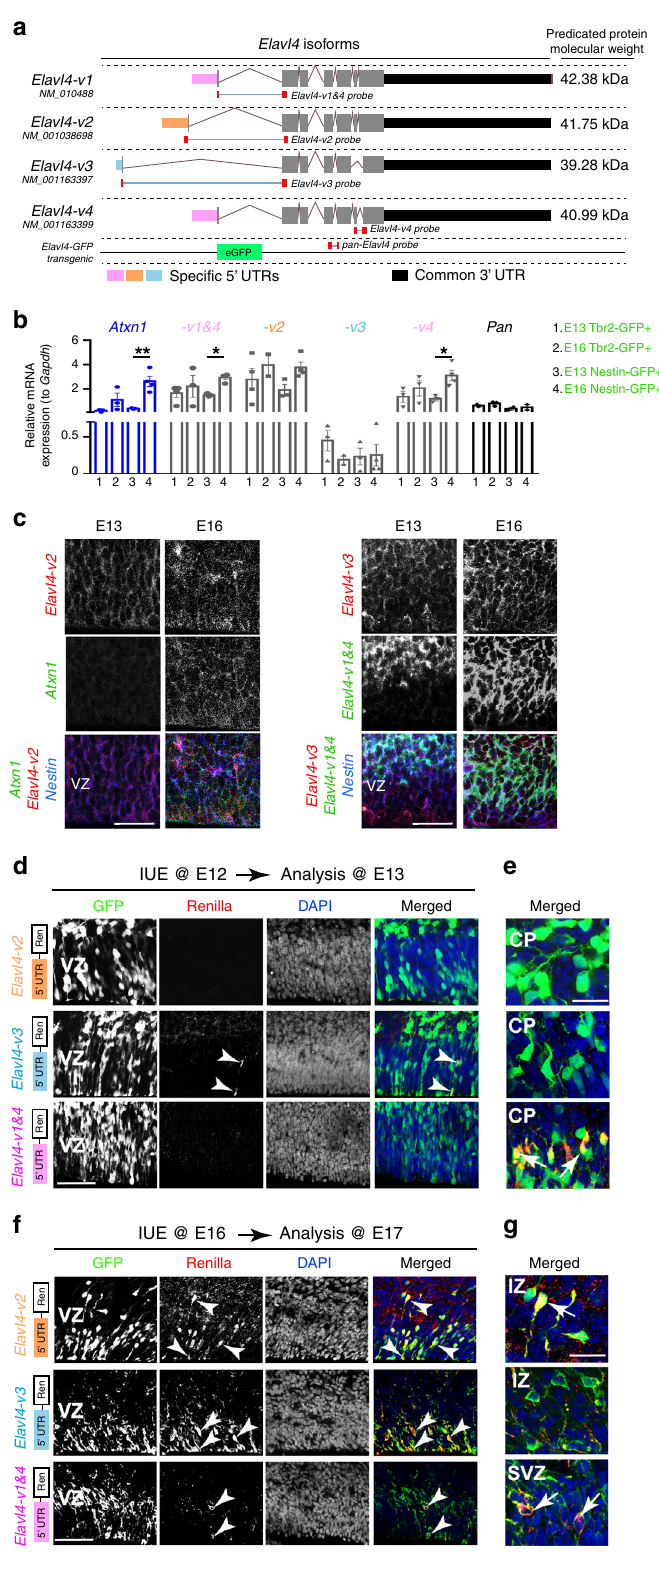
To test whether Celf1 acts on Elavl4 mRNA through the 3 ′ UTR or 5 ′ UTR, we cloned the 3 ′ UTR shared amongst all Elavl4 isoforms downstream of Luciferase ( Luc ) and the 5 ′ UTRs speci fi c to Elavl4-v2 , -v3 , -v1&4 (the Elavl4-v1 5 ′ UTR is indistinguishable from the -v4 5 ′ UTR; Fig. 2a) upstream of Renilla ( Ren ). LUC or